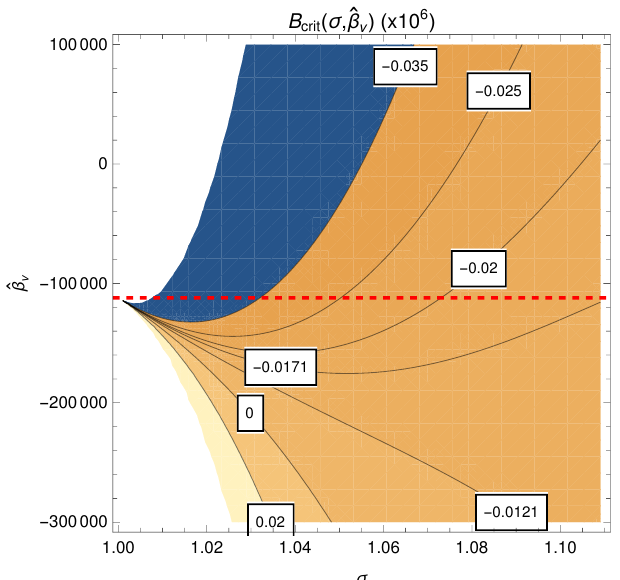
Figure 3. Some level lines B cr ( σ , ˆ β v ) =const. for T o = 1.0005 (the white boxes indicate the value of the constant). The grid-line ˆ β v = − 1.13 × 10 5 (in red) shows that, for ˆ β v > − 1.13 × 10 5 , B v is negative for all σ ∈ ( T o ,1 + Γ ) .